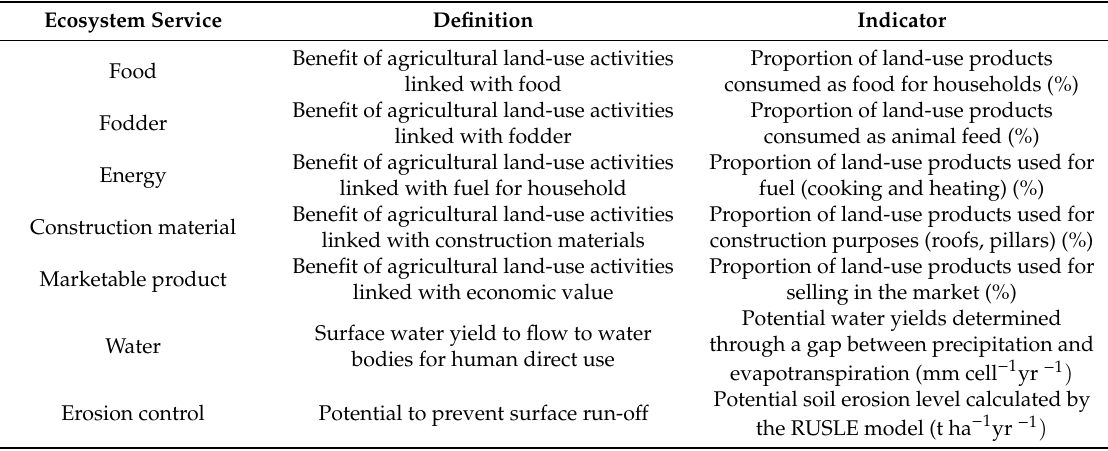
Table 1. Locally relevant agriculture related ecosystem services and indicators to assess the ecosystem services as identified in Koo et al.